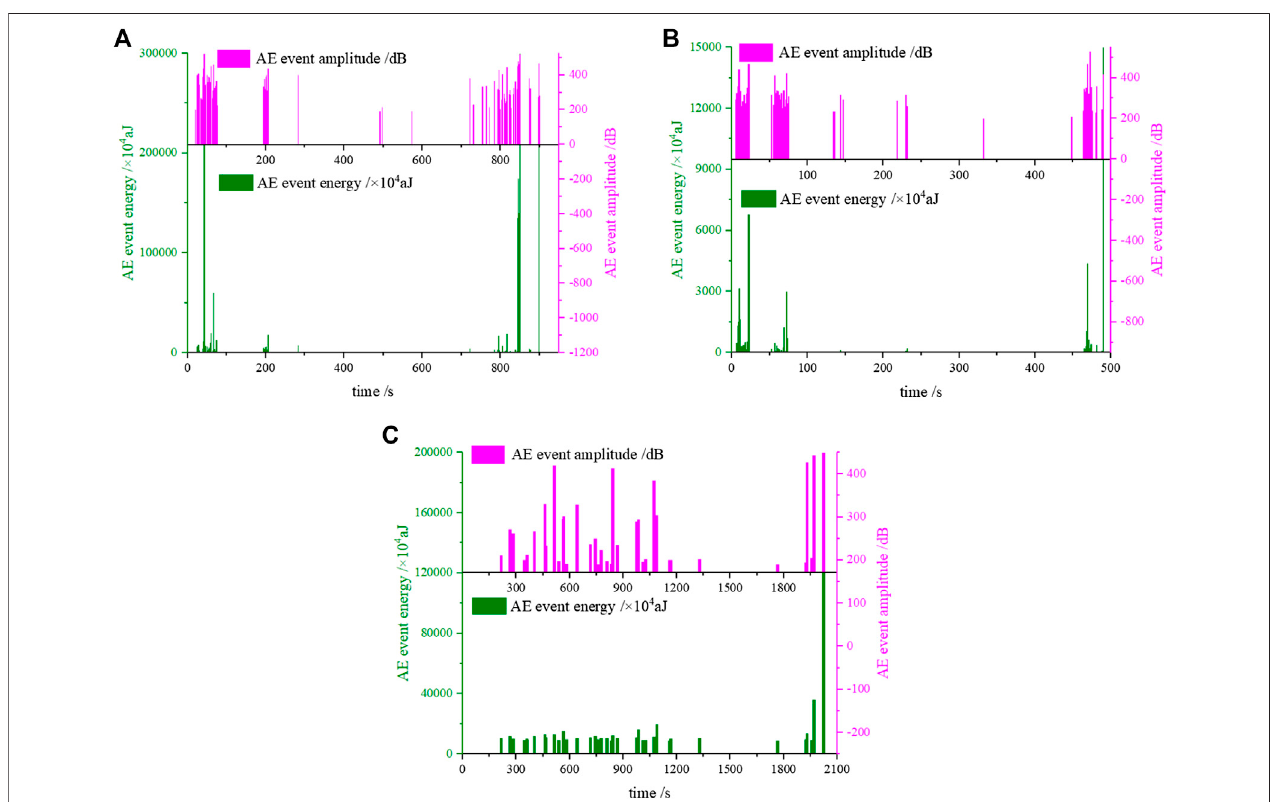
FIGURE 10 | The distribution of AE event amplitude and energy under different initial stresses. (A) σ 0 (cid:2) 2.5 MPa; (B) σ 0 (cid:2) 7.5 MPa; (C) σ 0 (cid:2) 12.5 MPa.